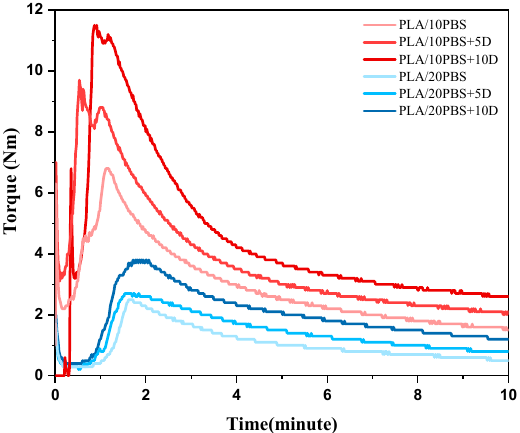
/ PBS blends with or without Figure 1. Mixing torque of the PLA/PBS blends with or without PDLA. Figure 1. Mixing torque of the PLA